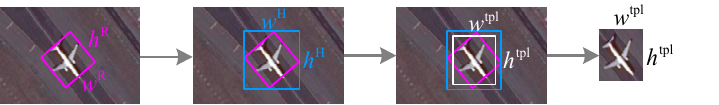
Figure 6. Determining the initial aircraft template image from the rotation detection results in the start frame.